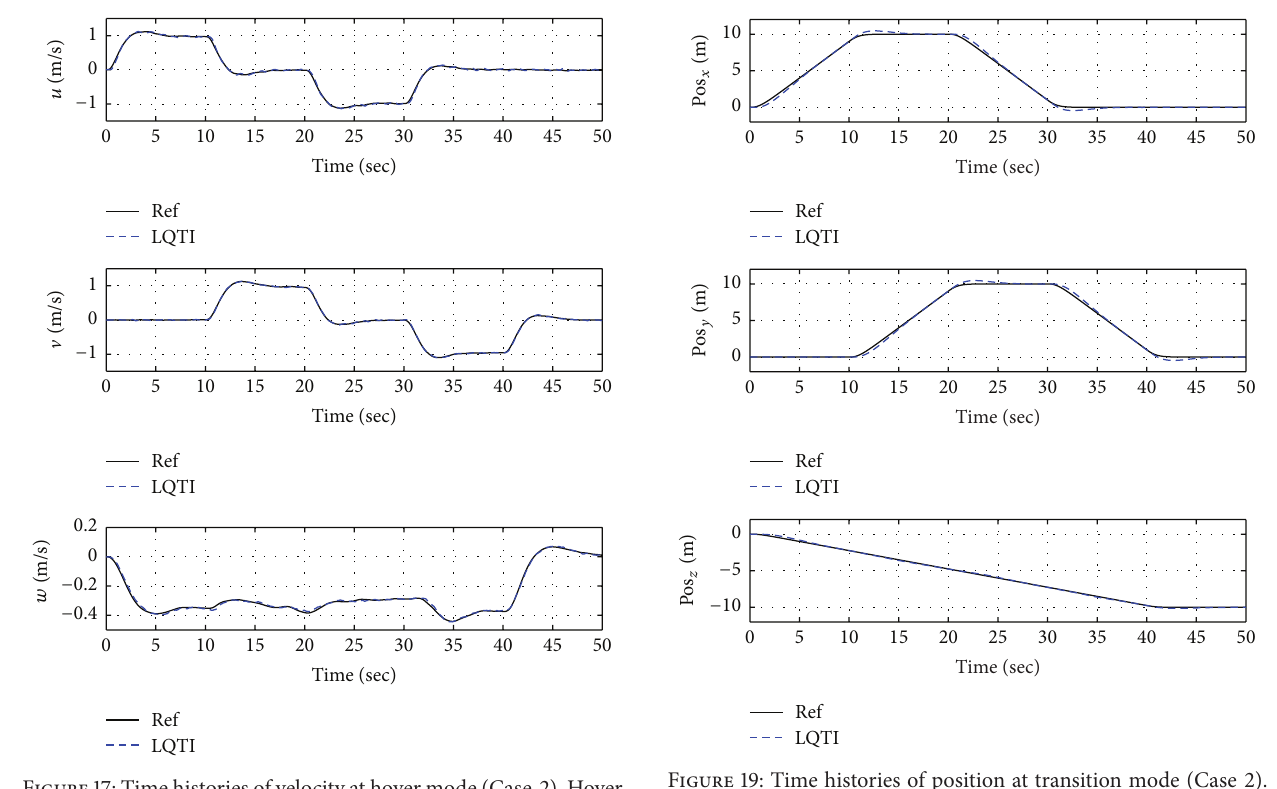
Figure 17: Time histories of velocity at hover mode (Case 2). Hover mode (0m/s).